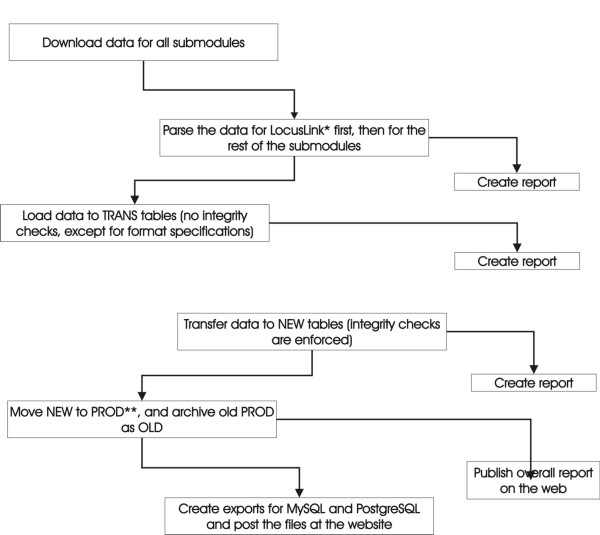
A workflow schema of GeneKeyDB creation and export to other RDBMS. *LocusLink is parsed first as other sub-modules depend on it with respect to the central key of the database. PROD refers to the current production stage database.